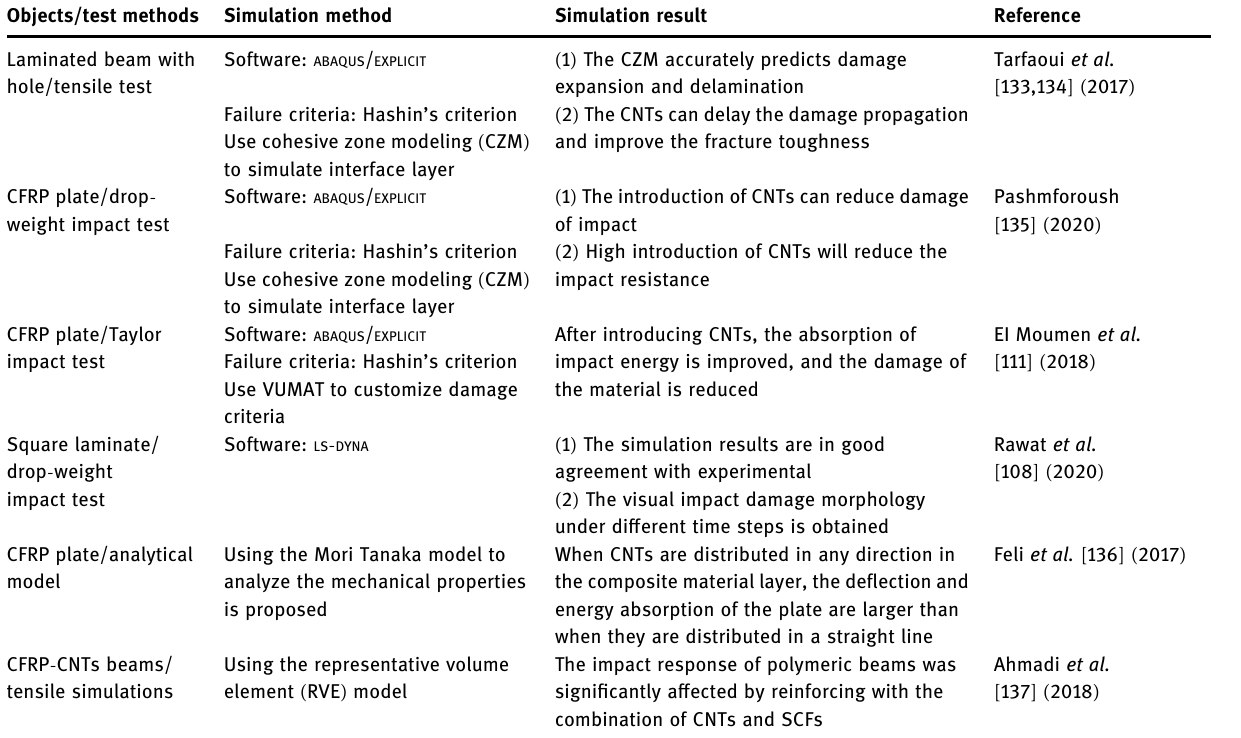
Table 3: Researches on the interlayer properties of multiscale composites of the CNT - reinforced FRP Objects/test methods Simulation